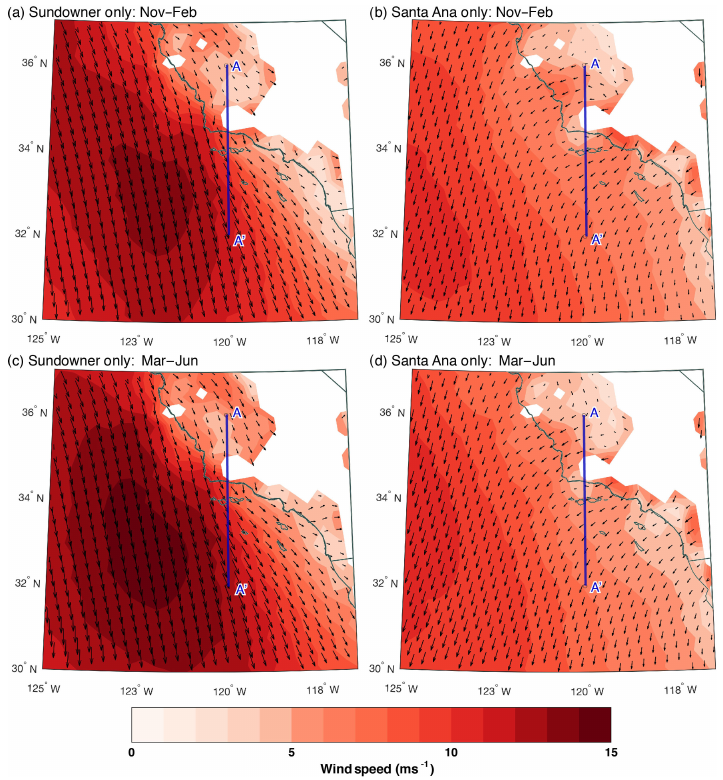
Figure 4. (a–d) Composite North American Regional Reanalysis 925hPa wind velocity magnitudes (filled contours, contour interval 1ms − 1 ) with vectors showing total wind direction (vector size is proportional to wind magnitude). Shaded white areas indicate areas in which NARR terrain exceeds 925hPa. The dark blue lines in each panel indicate the extent of the cross section used to produce the vertical cross sections shown in Fig.